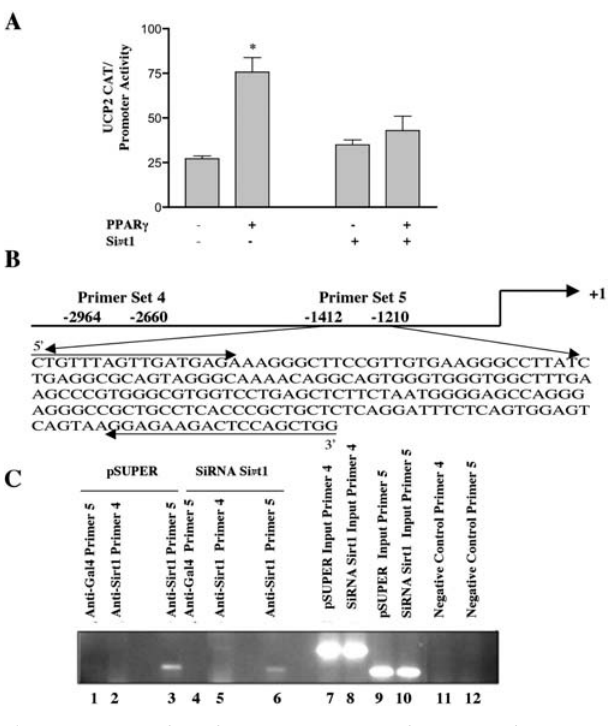
Figure 5. Sirt1 Binds at the UCP2 Promoter and Represses the Gene (A) In vitro CAT assay. 293T cells were transfected with a CAT reporter driven by the UCP2 promoter. Cells were also co-transfected with Sirt1 or not and with PPAR c or not, as indicated. CAT activity was determined ( n ¼ 3 experiments done in triplicate, * p , 0.05 in the no Sirt1 transfection experiment, ANOVA). (B) Schematic representation of the primer sets (arrows) in the UCP2 promoter (shown schematically and with excerpted DNA sequence). (C) Chromatin-immunoprecipitation (IP) was carried out on INS-1 control cells (lanes 1–3) or Sirt1 knockdown cells (columns 4–6) using Sirt1 antibody or a Gal4 control antibody, as indicated. PCR was carried out with the indicated primers. INPUT (columns 7–10) refers to PCR carried out on samples prepared prior to immunoprecipitation. Negative controls for the PCR (minus DNA) are also indicated (columns 11 and 12). DOI: